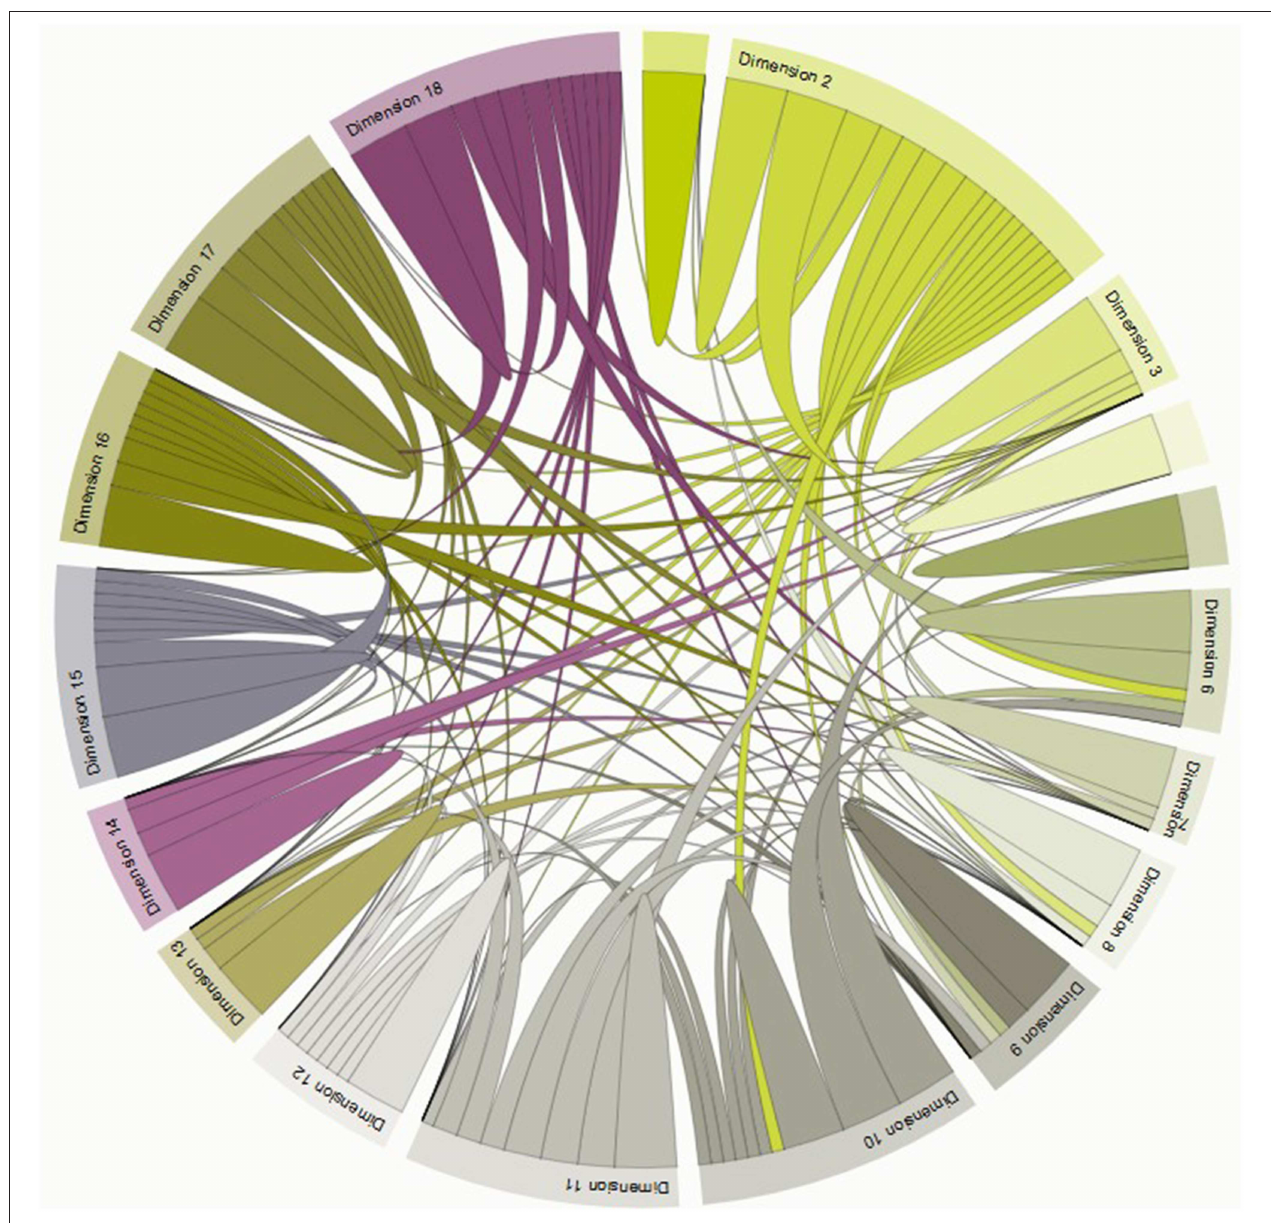
FIGURE 4 | Chord-diagram of quantitative